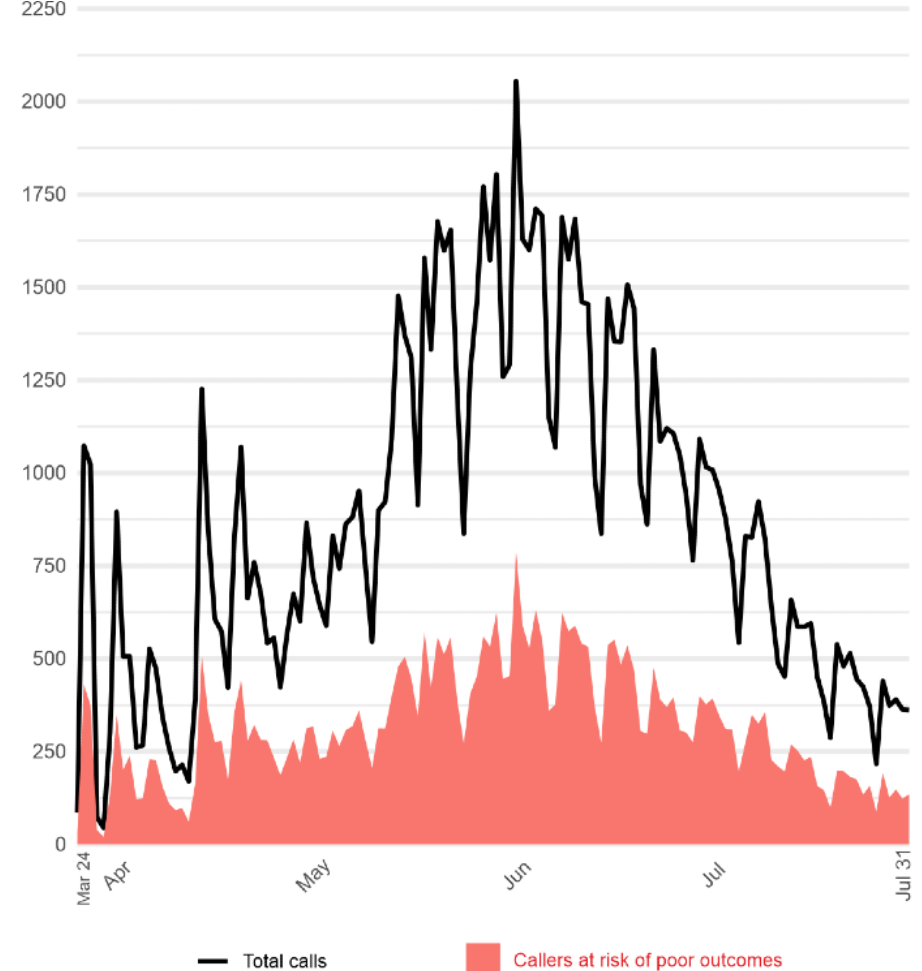
Figure 2. Total number of calls received daily by Telecoronavirus, including the numbers of callers deemed at risk of poor outcomes between March 24 and July 31, 2020 (Bahia,